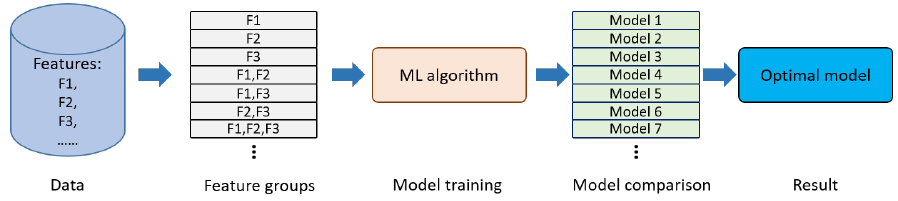
Figure 1. The pipeline of obtaining an optimal ML model for a data set with multiple features. Reprint with permission from Jianlong Zhou, Weidong Huang and Fang Chen (2020). Copyright 2020 IEEE Pacific Visualization Symposium